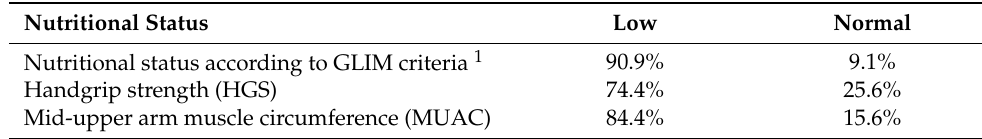
Table 4. Effect of various measurements of nutritional status on length of stay (LOS) greater than 5 days in Lebanese hospitals (n = 343).